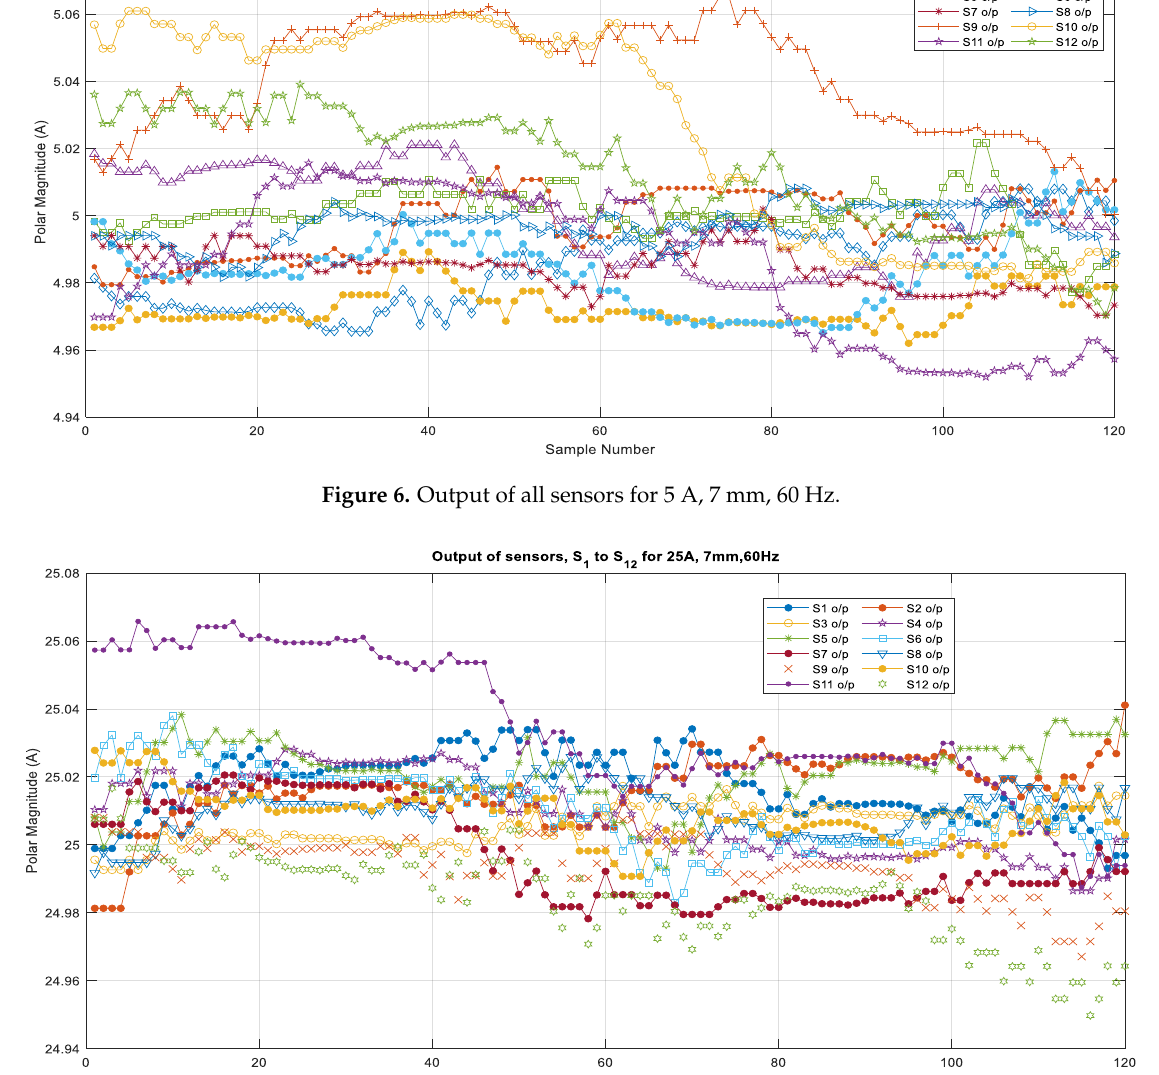
Figure 7. Output of all sensors for 25 A, 7 mm, 60 Hz.